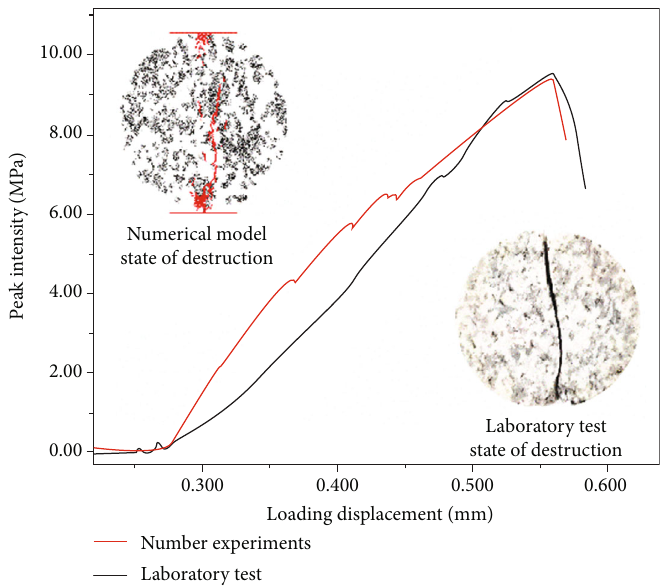
Figure 8: Calibration results of mesoscopic parameter in the numerical model.